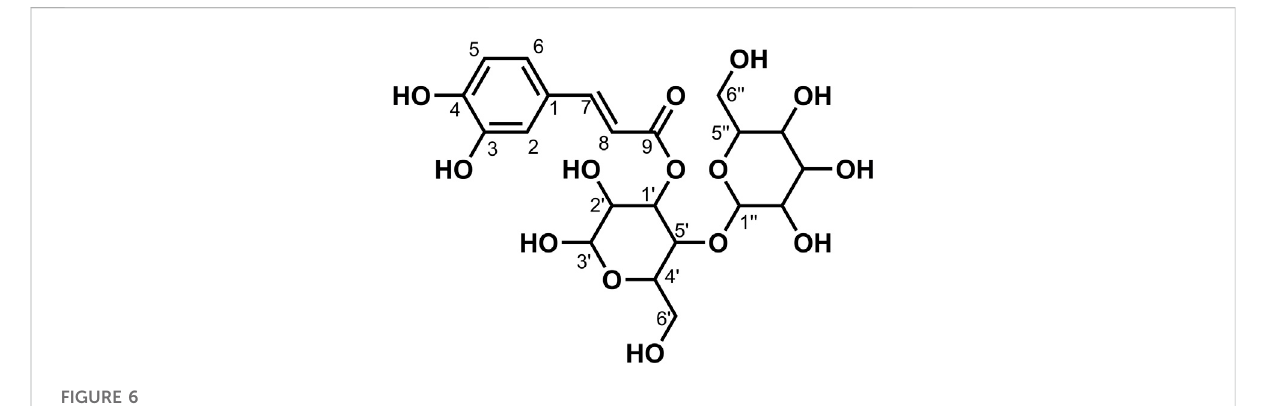
FIGURE 6 Chemical structure of compound 10